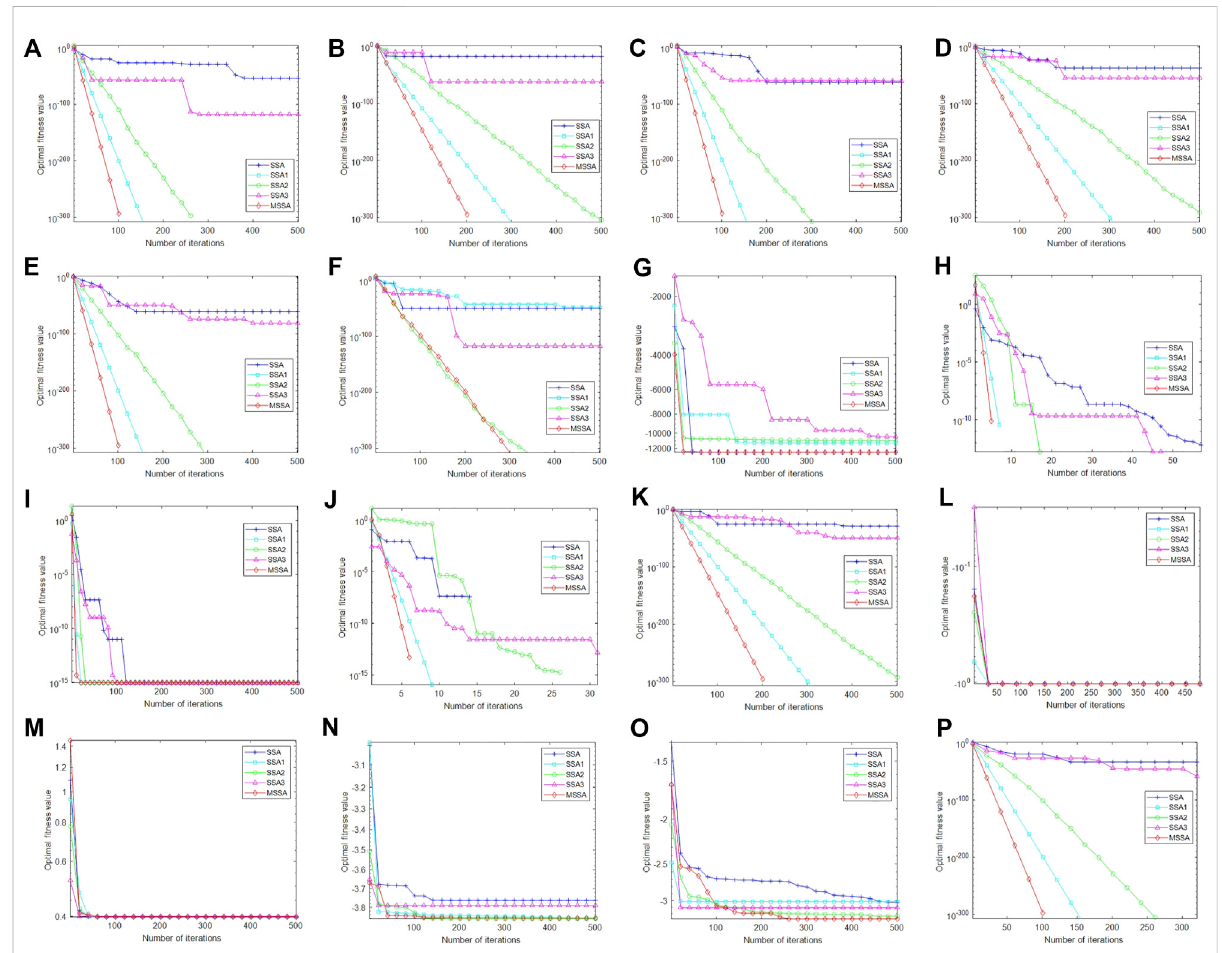
FIGURE 5 Meanconvergencecurveofthebenchmarkfunction. (A) f 1 meanconvergencecurve. (B) f2meanconvergencecurve. (C) f3meanconvergence curve. (D) f4meanconvergencecurve. (E) f5meanconvergencecurve. (F) f6meanconvergencecurve. (G) f7meanconvergencecurve. (H) f8mean convergence curve. (I) f9 mean convergence curve. (J) f10 mean convergence curve. (K) f11 mean convergence curve. (L) f12 mean convergence curve. (M) f13 mean convergence curve. (N) f14 mean convergence curve. (O) f15 mean convergence curve. (P) f 16 mean convergence